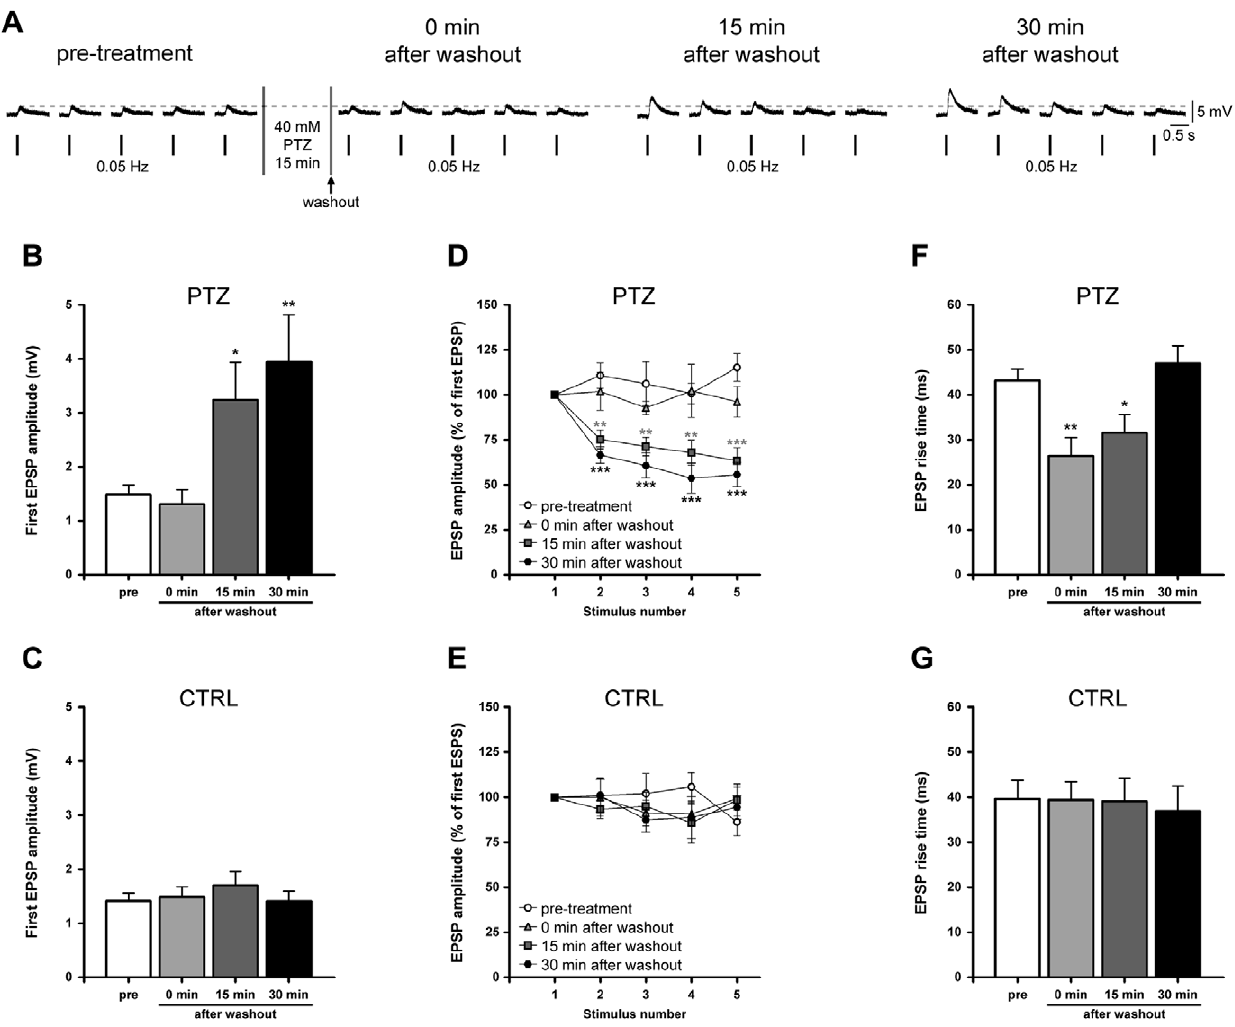
Figure 3. Epileptiform activity induces a use-dependent synaptic potentiation at B2 – B2 synapses. (A) Sample electrophysiological recordings of five consecutive EPSPs evoked at the basal rate of 0.05 Hz. Synapses were tested before and every 15 minutes after PTZ treatment and washout. An enhancement of synaptic strength was detectable at both 15 and 30 minutes after drug washout. (B) Bar graph of the mean amplitude of the first EPSP in treated synapses. EPSP amplitudes recorded before and at the end of PTZ exposure were similar. Conversely, a significant potentiation of 218.30 6 46.77% and 265.50 6 59.31% of pre-treatment value occurred at 15 and 30 minutes post-treatment, respectively. (C) Unchanged values were measured in the control group at any time-point. (D,E) Time course of EPSP amplitude in treated and untreated monosynaptic connections stimulated at 0.05 Hz. Values were expressed as percentages of the first EPSP amplitude to better appreciate the trend of EPSPs recorded at 15 and 30 minutes after PTZ washout. (F) Bar graph of EPSP rise times measured at each experimental time-point, showing that epileptiform activity temporarily speeded up the kinetics of release. (G) No significant difference was found in control group. basal EPSP amplitudes recorded before (1.65 6 0.20 mV) and soon after the treatment (1.44 6 0.26 mV) where no depression was detected. In the control group, no significant variation in the EPSP amplitude was observed at the different time-points (mean basal EPSP amplitude: pre-treatment: 1.40 6 0.16 mV; 0 min after washout: 1.43 6 0.20 mV; 15 min after washout: 1.56 6 0.19 mV; 30 min after washout: 1.45 6 0.13 mV; n = 6; Fig. 3E). In both groups, none of the recorded neurons displayed spontaneous activity in the time window between stimulations, confirming that Helix neurons are generally silent in culture. These results may indicate the presence of a novel form of synaptic potentiation, as a late rebound of epileptiform activity, which is ‘‘use’’- but not time-dependent, whereby the increased strength is similar at 15 and 30 minutes following PTZ washout.